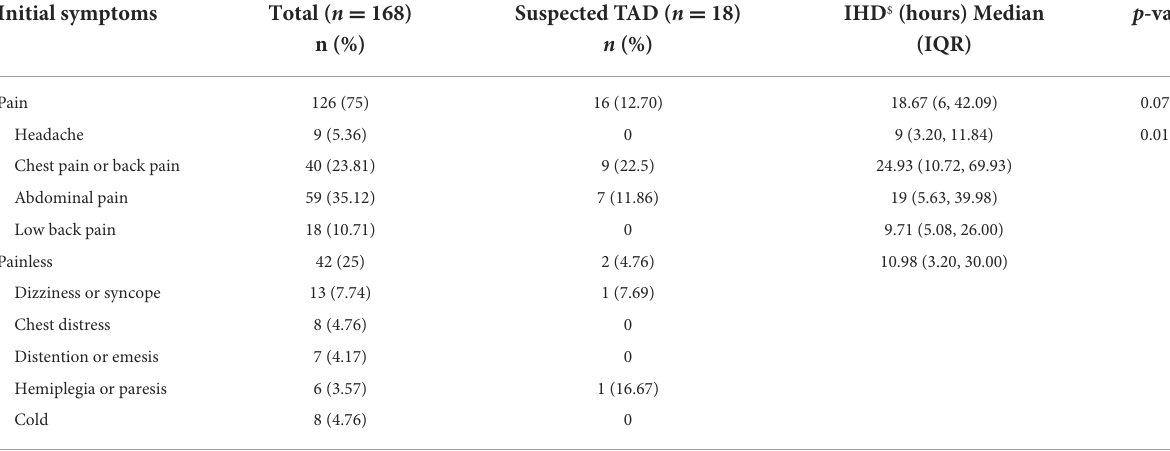
TABLE 2 Initial symptoms of TAD deceased whose prior symptom was not sudden